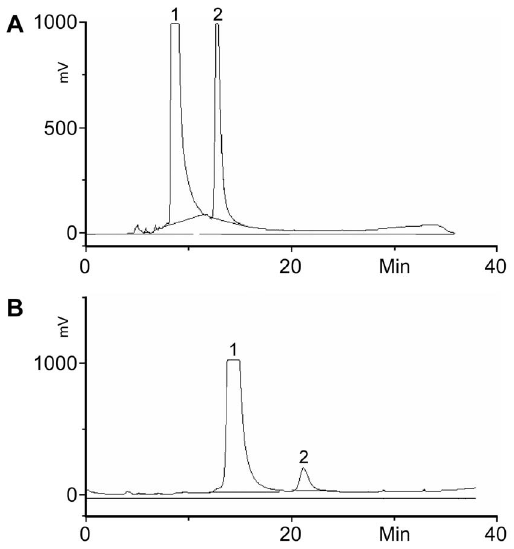
Fig. 7. HPLC chromatograms of SAT I (A) and SAT IV (B) assays with calf spleen microsomes; calf spleen microsomes were extracted with Triton. The resulting extract was tested for SAT I (A) and SAT IV (B) activity by incubation with the respective BODIPY- labelled substrates for 1 h at 37 u C. The presence of the respective activity was indicated by the presence of the product (peak 2) next to